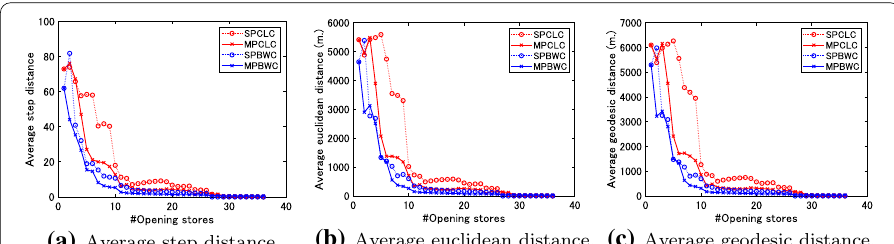
Fig. 7 Average distance between actual and predicted locations (Hachioji): The red dotted, the red solid, the blue dotted, and the blue solid lines represent the average distances between predicted locations by SPCLC, MPCLC, SPBWC, and MPBWC, and the actual location. A small average distance means that the locations of the actual store and the predicted node are close to each other, which means that the prediction can be made accurately